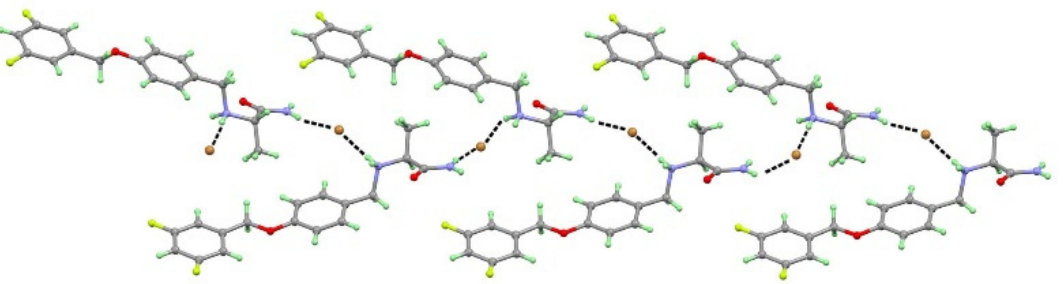
Figure 3. SAF cations and hydrobromic acid (HBr) anions form a one-dimension zigzag chain structure.